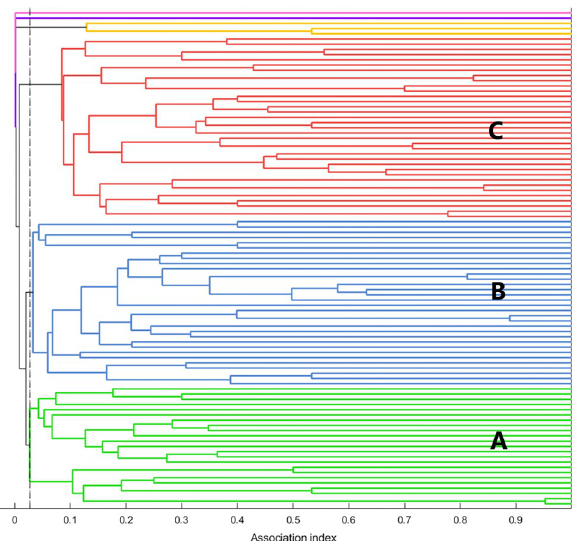
Fig 4. Social network dendrogram for identified clusters of estuarine-resident dolphins in North Carolina. Hierarchical cluster dendrogram from the social network analysis of estuarine-resident common bottlenose dolphins ( Tursiops truncatus ) in North Carolina). The analysis includes all dolphins with � 7 sightings from 1995–2018, resulting in a sample size of 95 individuals and 942 sightings. Six clusters were identified. The three large clusters are labelled A-C. One cluster comprised three individuals (Cluster D, yellow lines), and two clusters comprised a single individual (Clusters E, purple, and F, pink). The dashed vertical line indicates the mean association index (HWI) and serves as the cutpoint for identifying significant